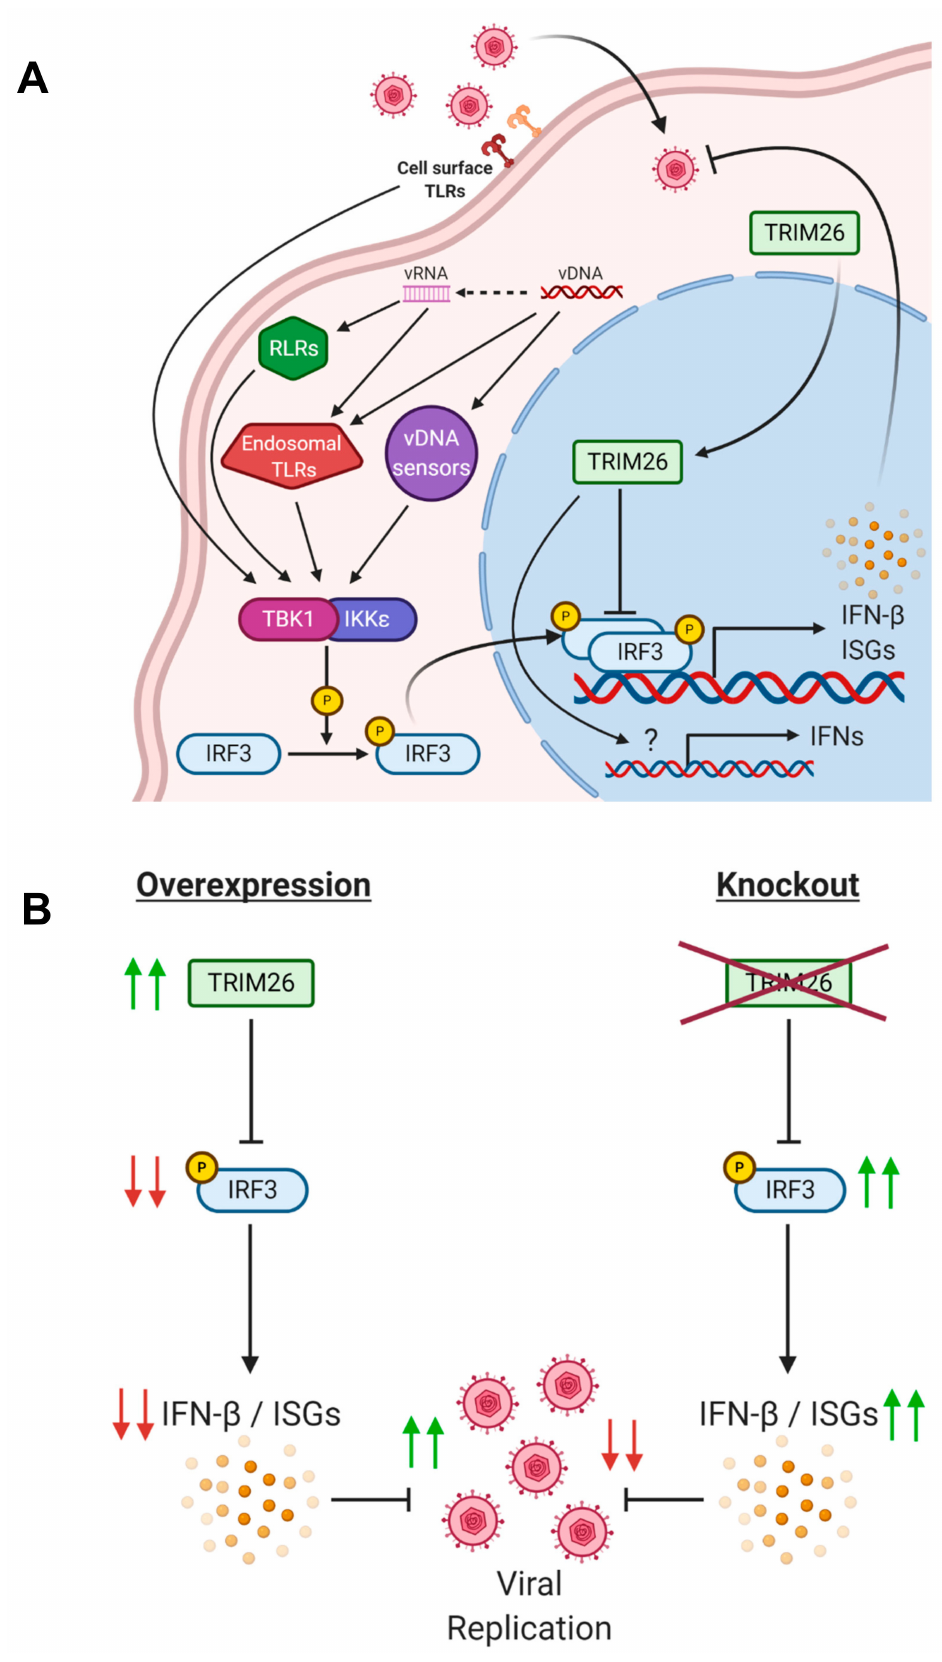
Figure 7. ( A ) Proposed signaling pathways regulated by HSV-2 infection and TRIM26 activation. IRF3 can be phosphorylated, and thereby activated by the TBK1- IKK ε complex that is induced